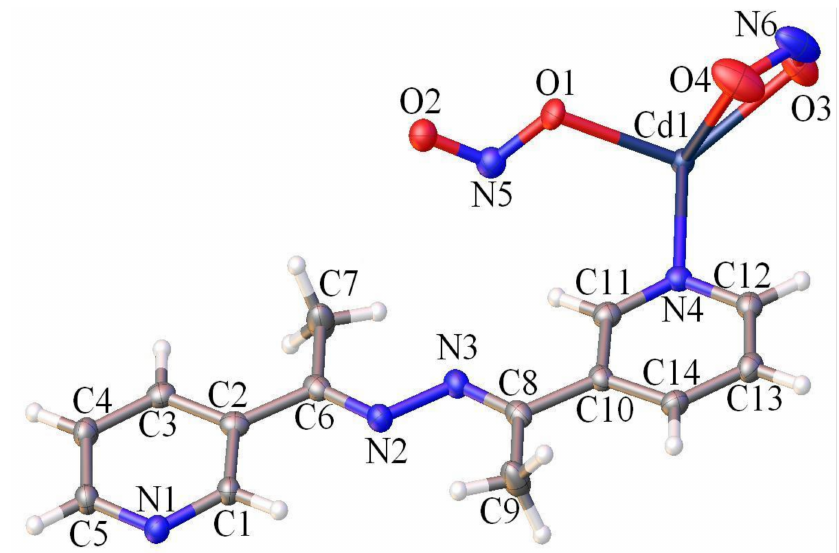
Figure 4. Asymmetric unit of the [Cd(L)(NO 2 ) 2 ] n .